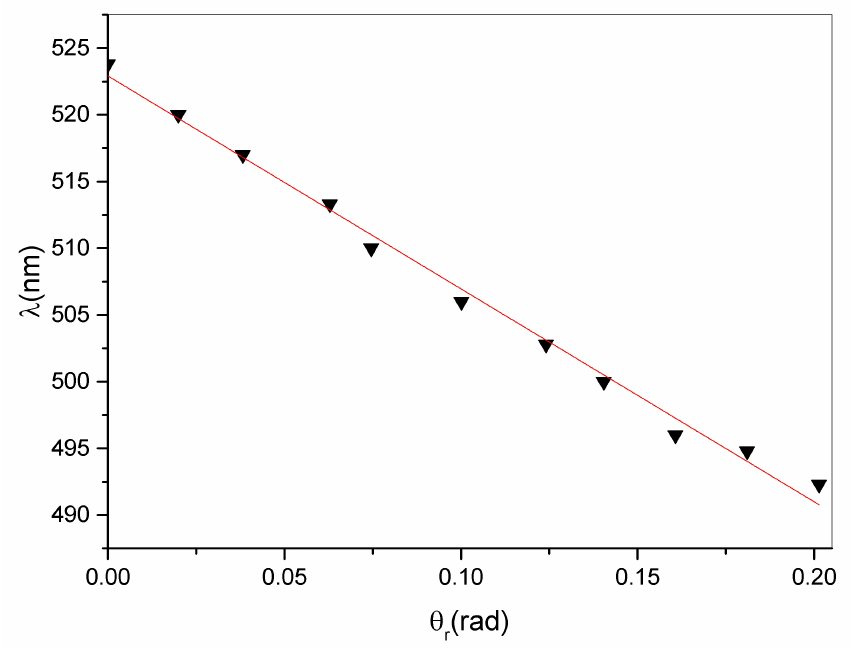
Figure 10. Position of the minimum of the reflected peak as a function of the rotation angle θ r